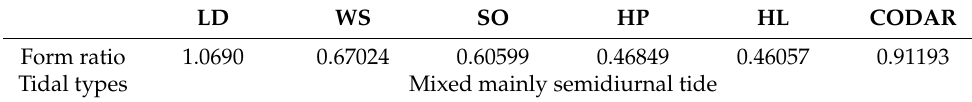
Table 5. Results of the form ratio and tidal patterns from the tide-gauge stations and HFR. LD WS SO HP HL CODAR Form ratio 1.0690